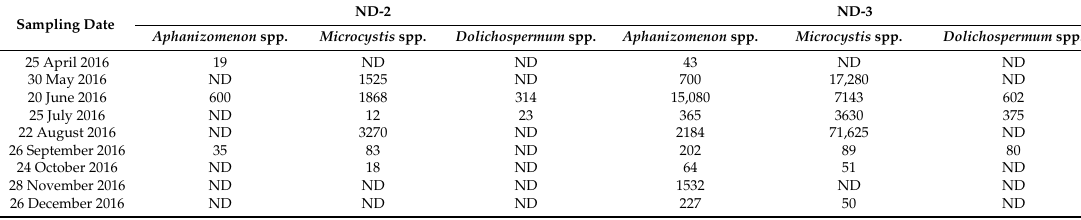
Table 3. Cell densities (cells mL − 1 ) of three major cyanobacterial genera of monthly water samples from the Nakdong